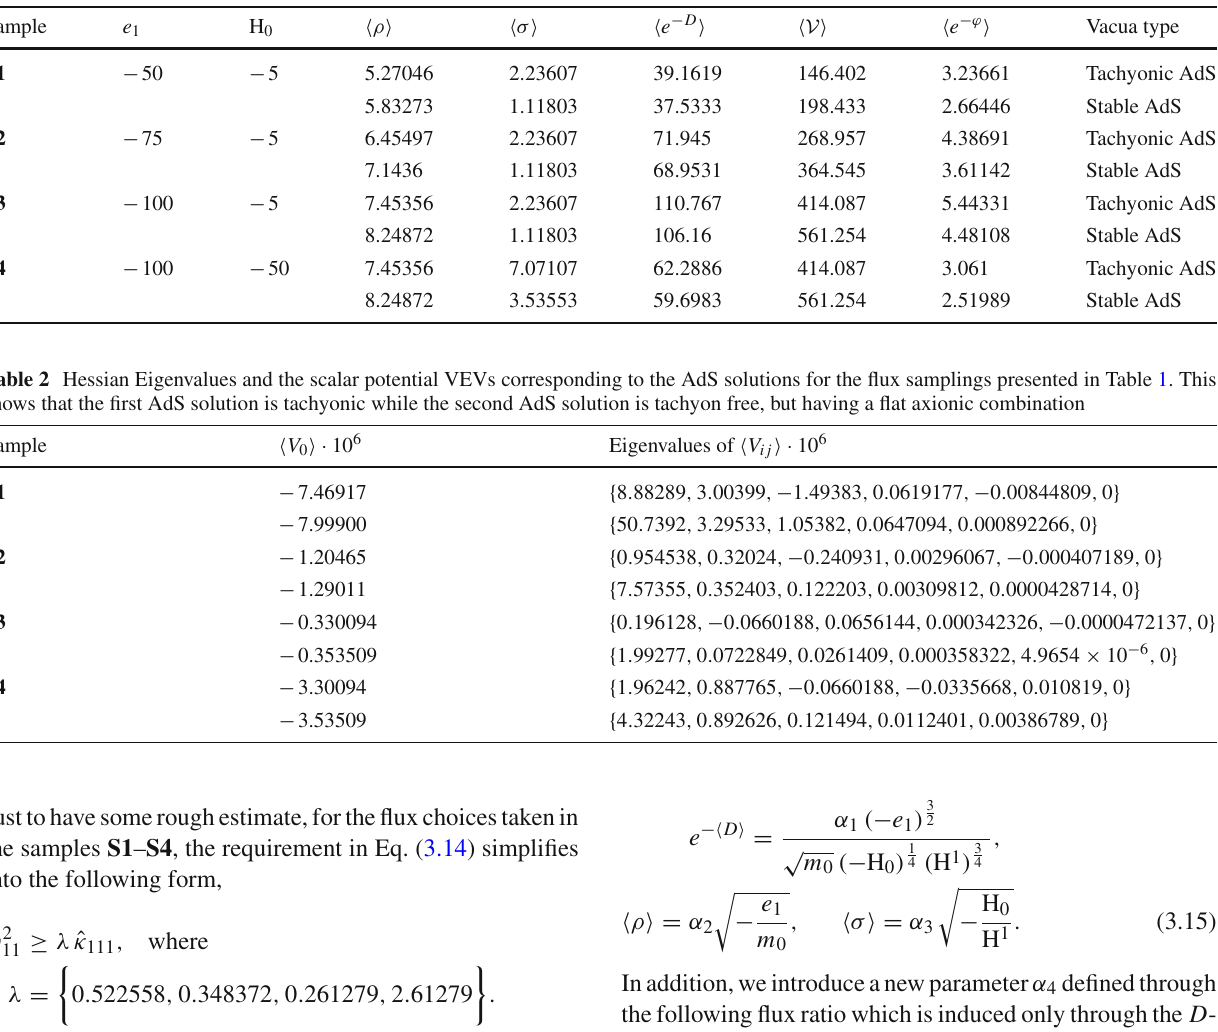
Table 1 Numerical samplings for tachyonic and stable AdS solutions where other fluxes are set as: e 0 = 0 , m 1 = 0 , m 0 = 1 , H 1 = 1 and ˆ w = 0, leading to (two of the three) axions being stabilized as (cid:10) b 1 (cid:11) = 0 and (cid:10) ξ 0 (cid:11) H 11